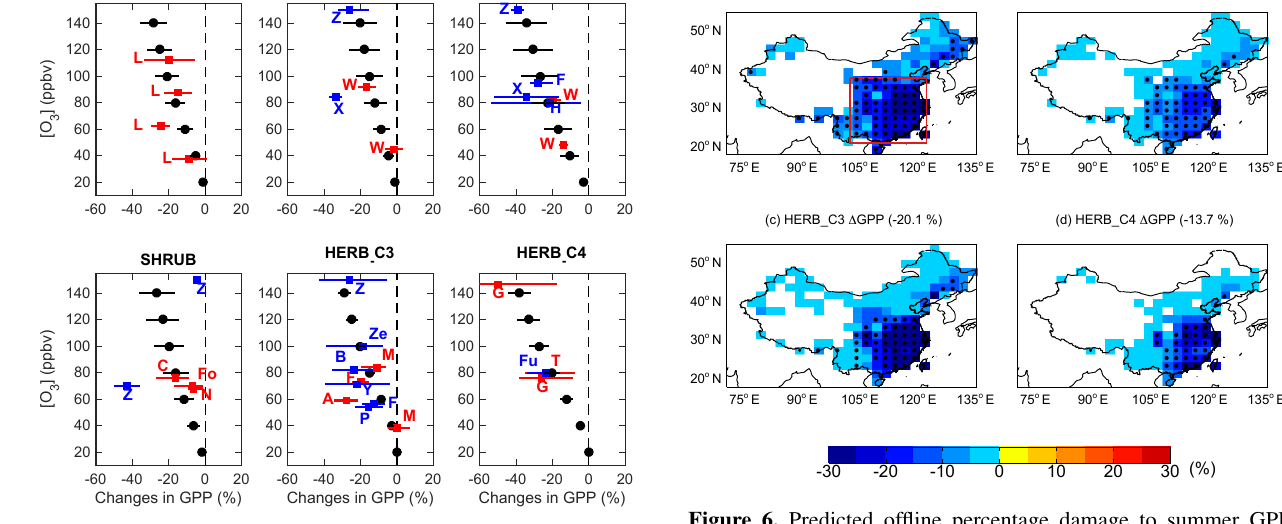
Figure 6. Predicted offline percentage damage to summer GPP caused by O 3 . Panels show the damages to (a) ENF (evergreen needleleaf forest), (b) DBF (deciduous broadleaf forest), (c) C3 herbs, and (d) C4 herbs over China in the year 2010. Simulations are performed with the climate model ModelE2–YIBs, which does not feed O 3 vegetation damages back to affect biometeorology, plant growth, and ecosystem physiology. The results are averaged for the low and high damaging sensitivities: ( 1 (G10ALLHO3_OFF + G10ALLLO3_OFF) / G10ALLNO3 − 1) 2 × 100%. The average value over the box domain of panel (a) is shown in the title bracket of each subpanel. Significant changes ( p <0.05) are marked with black